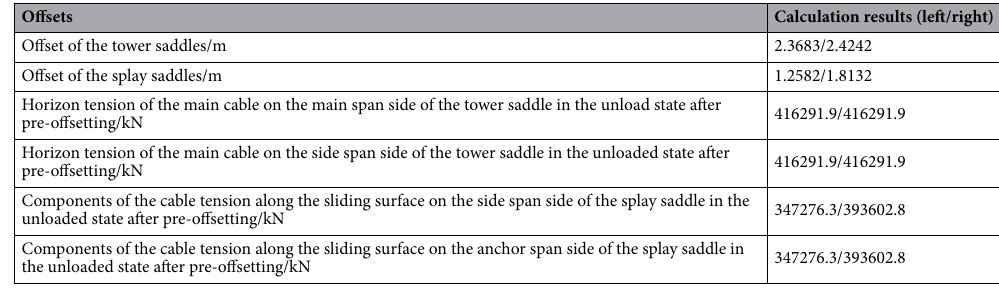
Table 1. Results of cable saddles pre-offsets adopting the method of this paper.